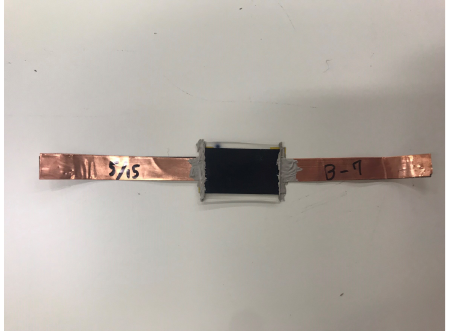
Figure 2. Photo of a thin stacked